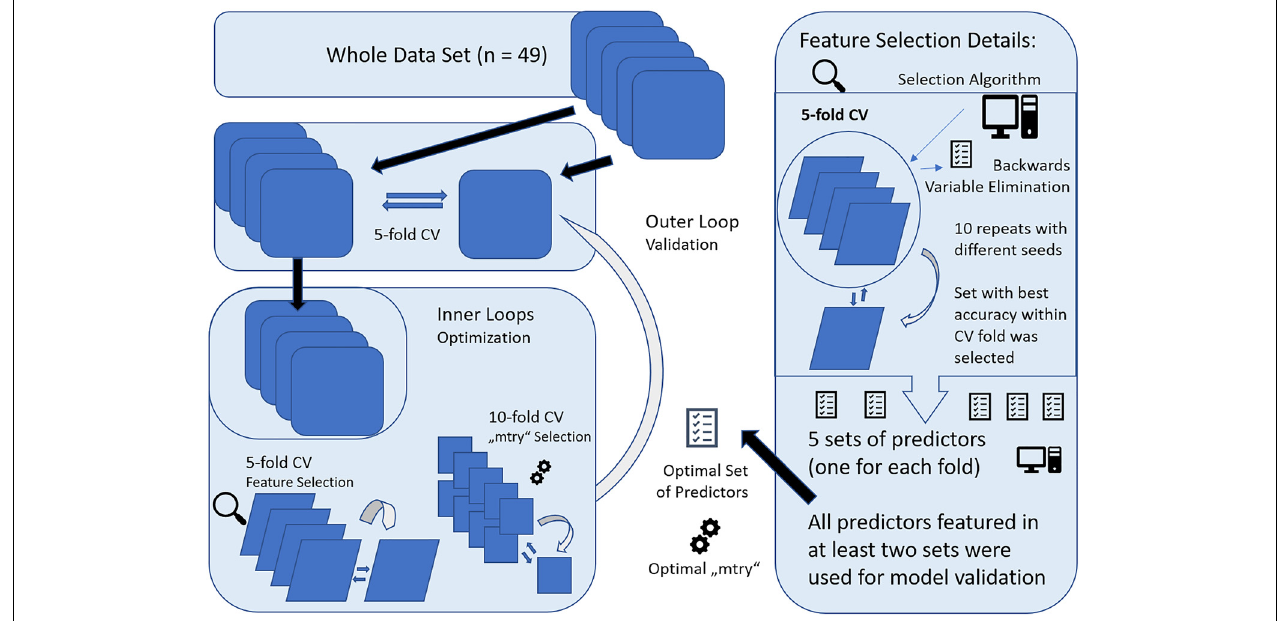
FIGURE 2 | Graphical representation of the nested cross-validation (CV) design, consisting of a inner and outer loop. The inner loop was performed for model optimization with feature selection and setting of optimal parameters (“mtry”) for RandomForest (RF). For feature selection, fivefold CV was applied and all variables selected more than once across the runs were included within 10-fold CV for “mtry” selection. The resulting model was then applied to the validation set, forming the outer loop. This was repeated for all folds of the fivefold CV design for outer loop. Finally, the whole nested CV procedure was repeated 10 times and results were